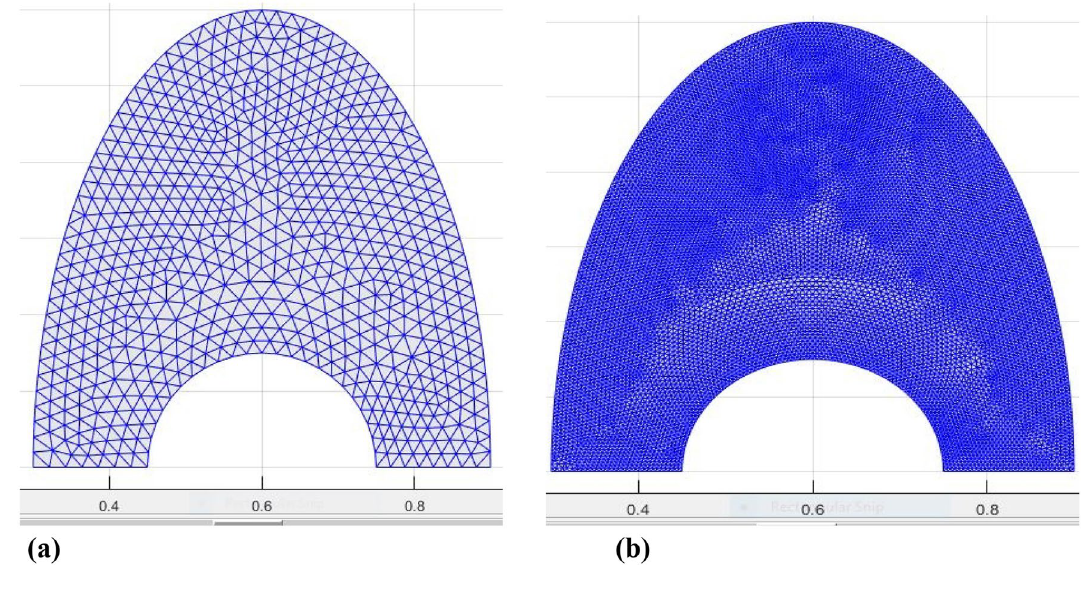
Figure 3. The grid presentation of the proposed model.